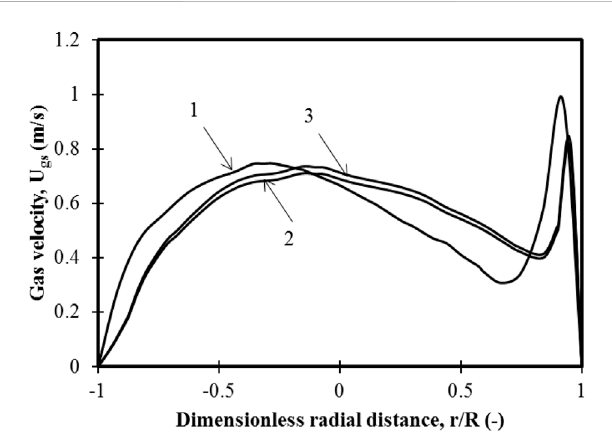
FIGURE 4 Variation of gas velocity for three different grids for position 2 of Figure 1 at steady state for super fi cial velocity of 0.3 m/s and 100% small particlesofthebinarymixture:1.173040meshelements;2.267786mesh elements; 3.497568 mesh